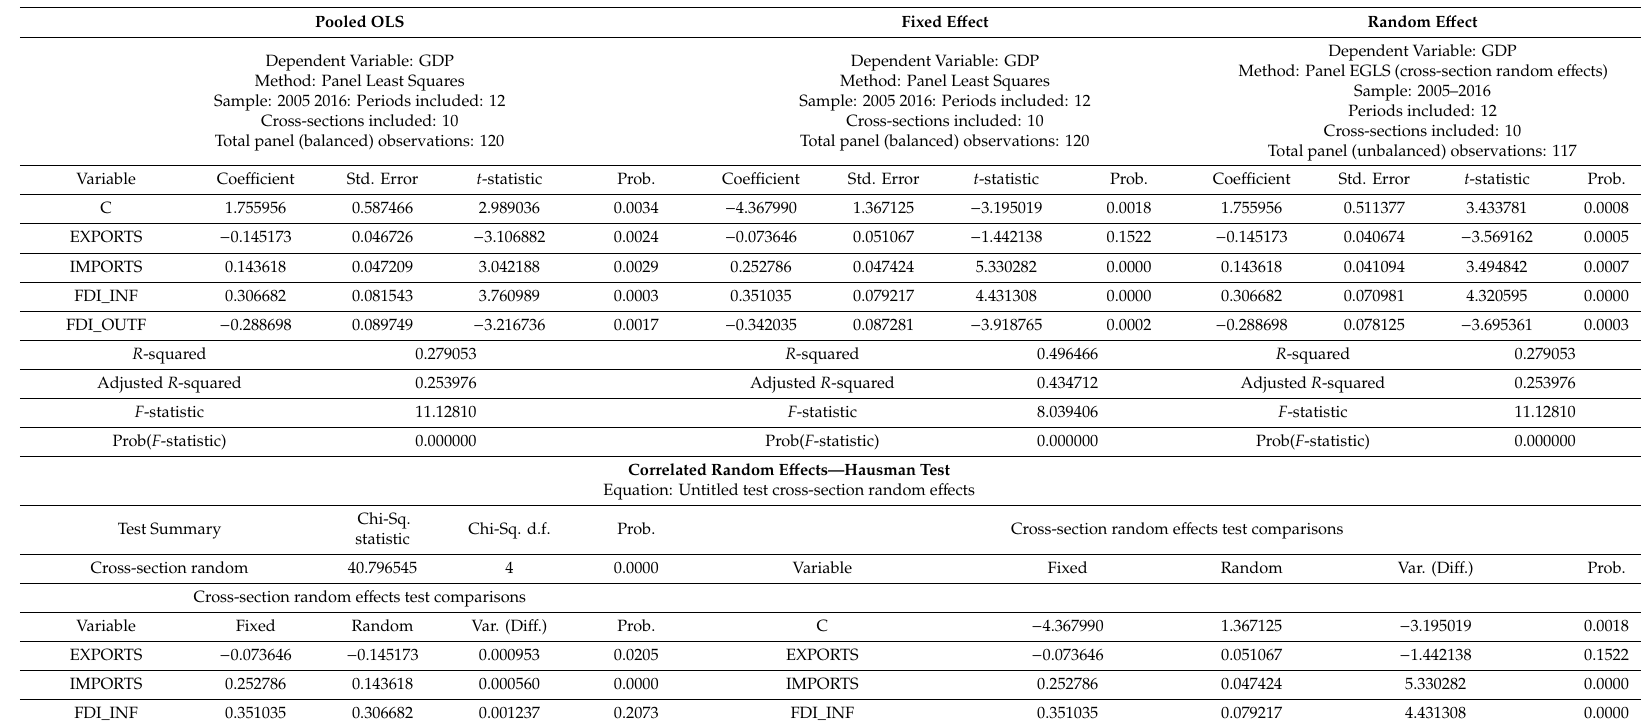
Table 4. Pooled ordinary least squares (OLS), fixed e ff ect, random e ff ect and Hausman